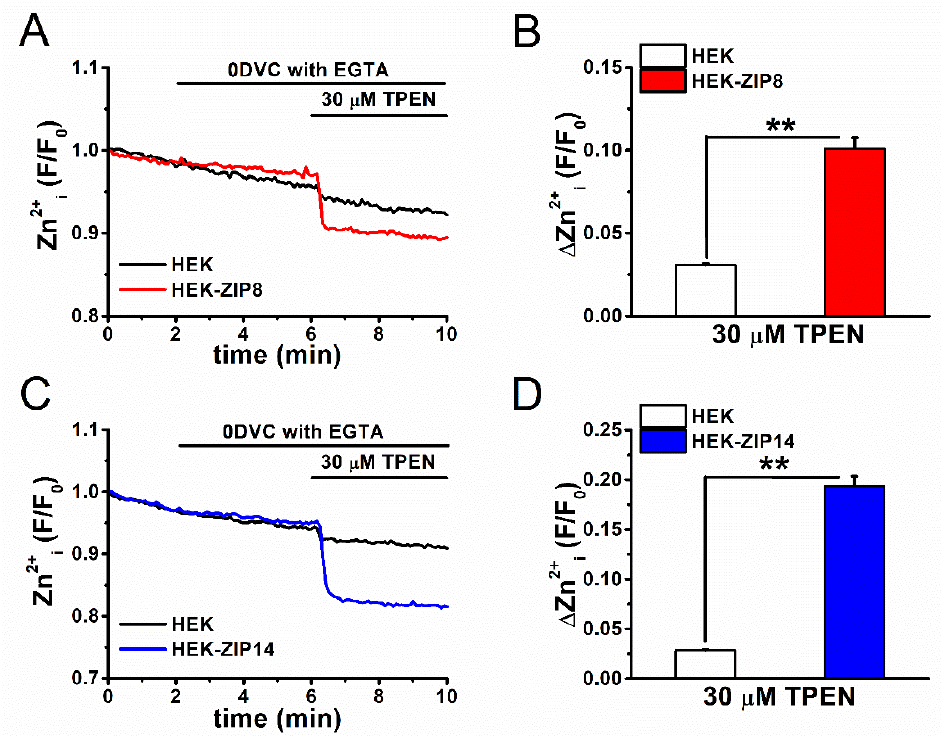
Figure 7. The basal Zn 2+ components in ZIP8- and ZIP14-expressing cells. TPEN-sensitive basal Zn 2+ components assayed with FluoZin-3 were compared between HEK cells with and without expression of ( A , B ) ZIP8 and ( C , D ) ZIP14. Extracellular Ca 2+ and Zn 2+ was removed by 0DVC with EGTA and cells were treated with 30 µ M TPEN. ( B ) Fluorescence signal was measured as Zn 2+ i (F/F 0 ) and ( D ) the peak change by TPEN was plotted (mean ± SEM; B: n = 153 and n = 153 for HEK and HEK-ZIP8 cells, respectively, and three independent experiments each; ** p < 0.01; D: n = 153 and n = 153 for HEK and HEK-ZIP14 cells, respectively, and three independent experiments each; ** p < 0.01).